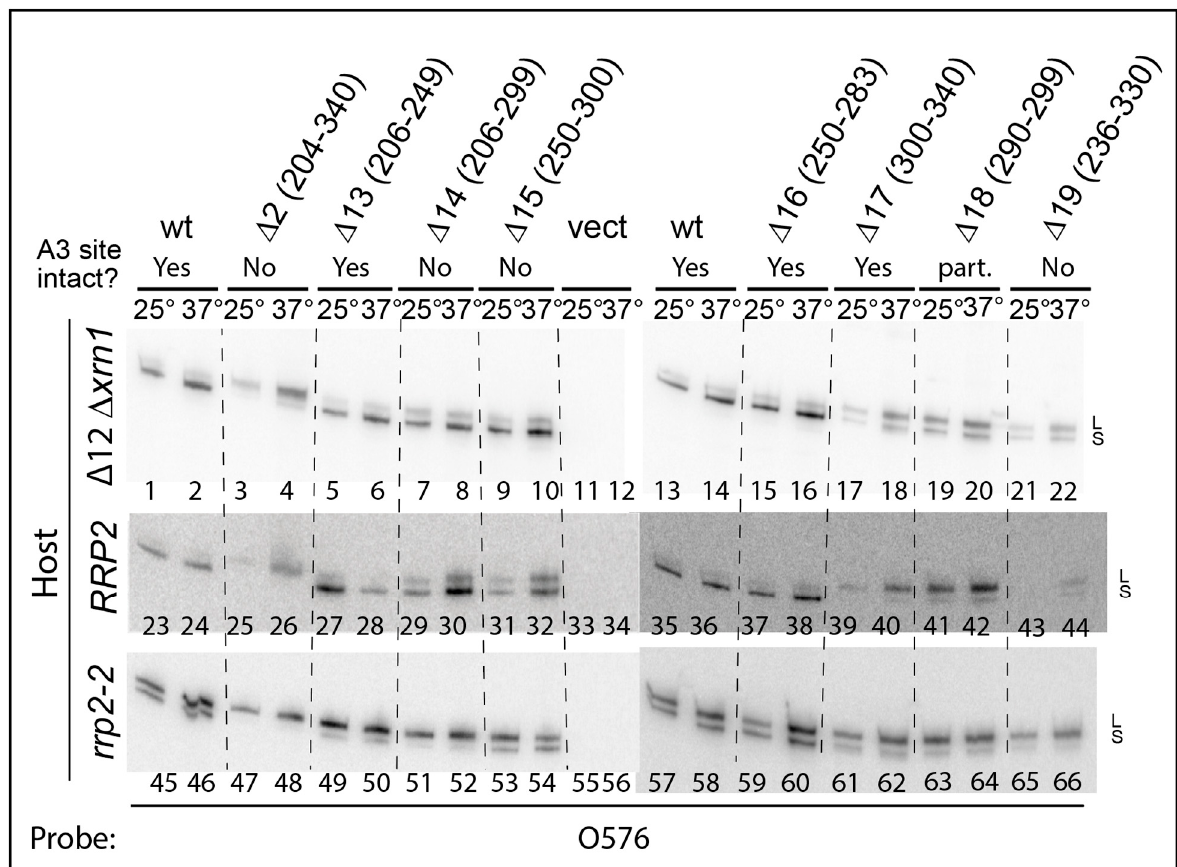
Figure 3. Northern analysis of RNA extracted from ∆ rpa12 ∆ xrn1 (top), RRP2 (middle), and rrp2-2 (bottom) each carrying pDK16-tag or one of its ITS1 deletion derivatives. Total rRNA was fractionated by electrophoresis on acrylamide gels and probed with O576 on northern blots. See Figures S2 and S3 for uncropped autoradiograms.